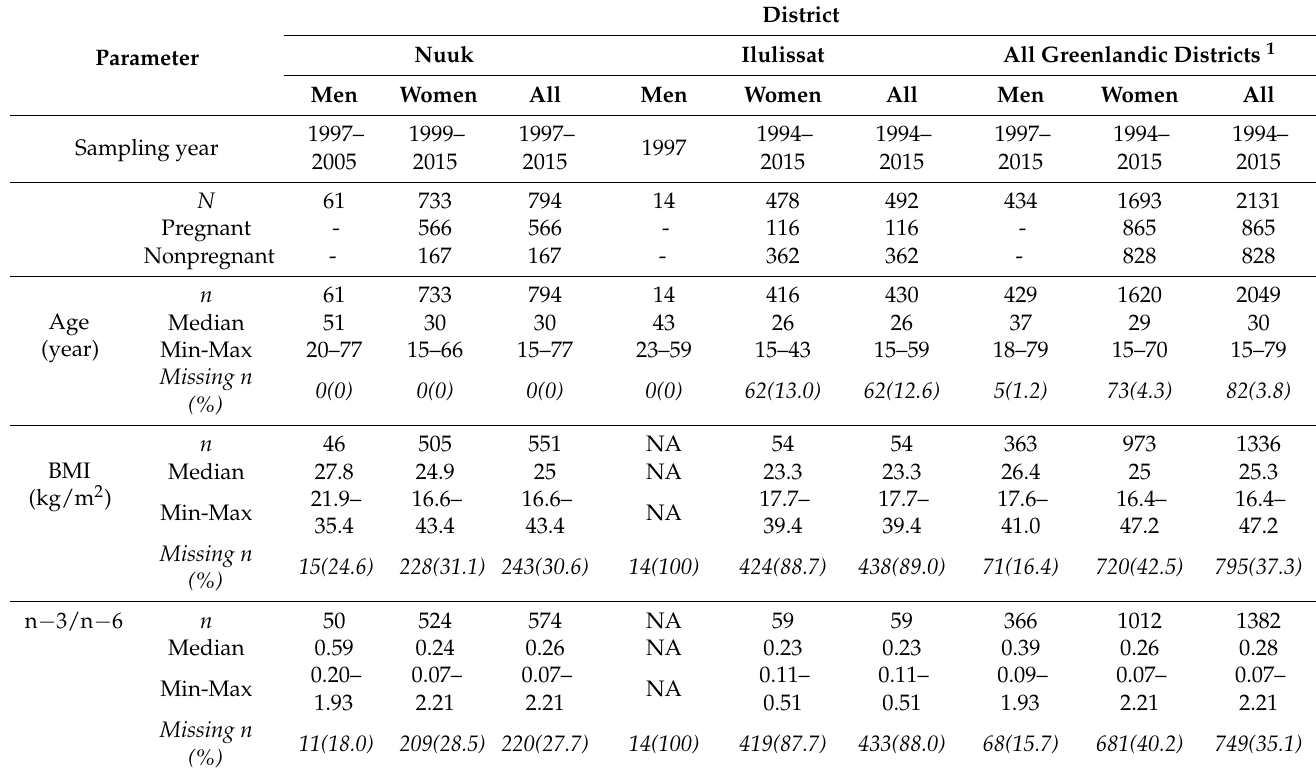
Table 2. Characteristics of Greenlandic